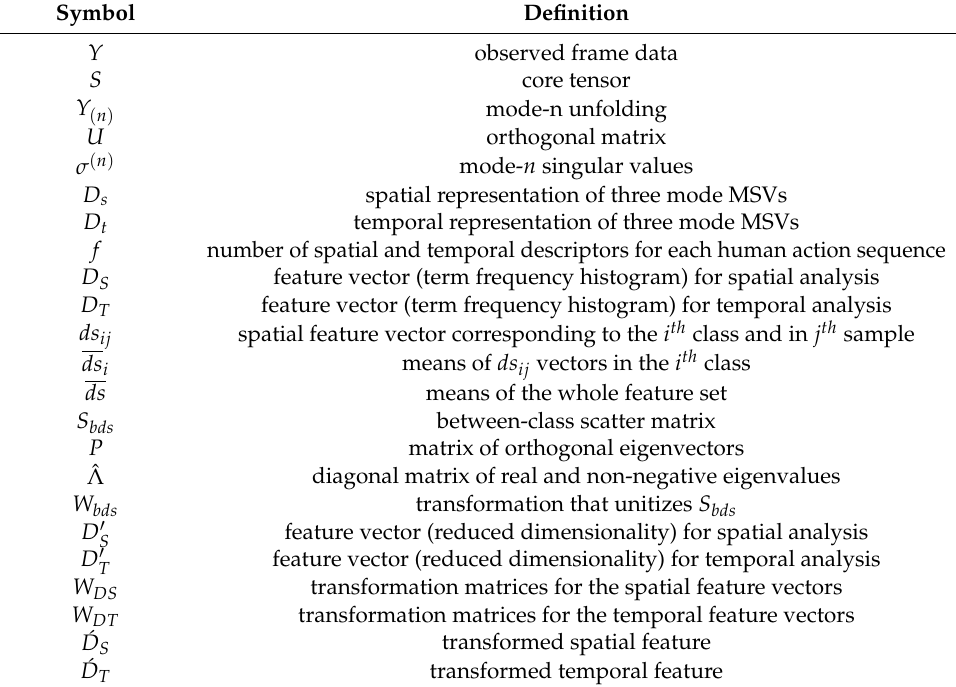
Table 1. Basic notations and